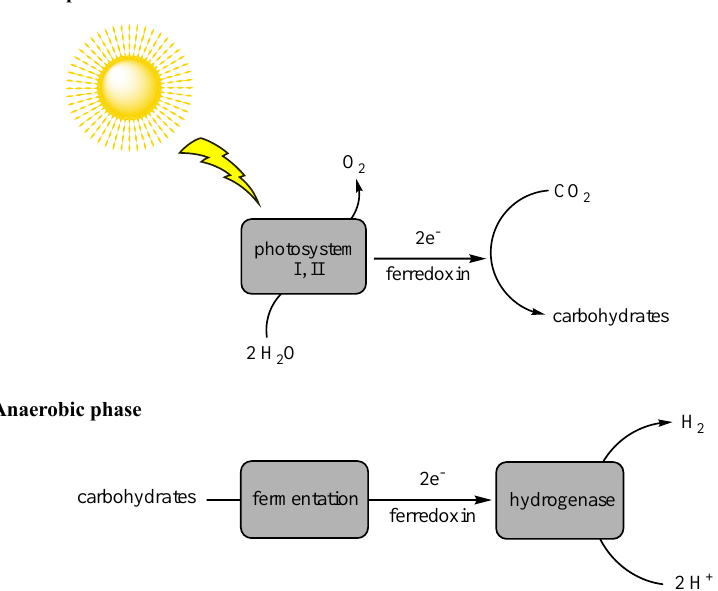
Figure 3. Process of hydrogen production via indirect photolysis.